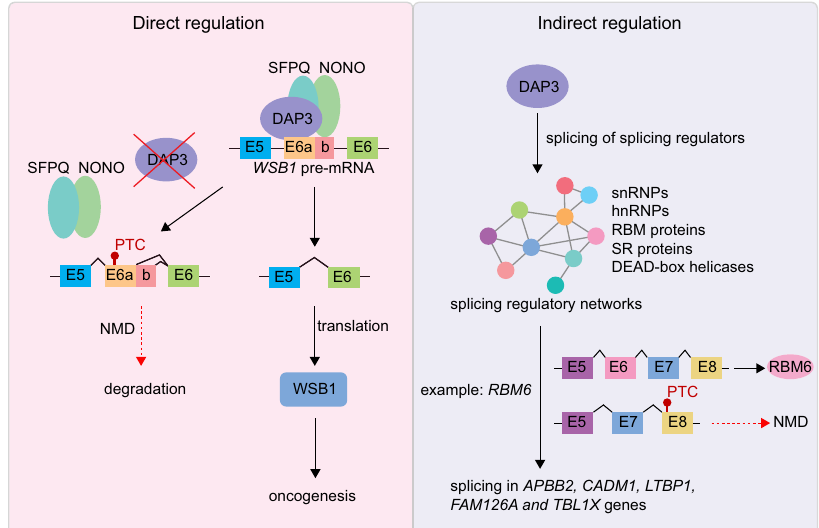
Fig. 8 Multilayered control of splicing regulatory networks by DAP3 leads to widespread alternative splicing changes in cancer. There are two distinct mechanisms of how DAP3 exerts its splicing regulatory functions. First, DAP3 directly binds to target RNA and mediates the recruitment of splicing factors, such as SFPQ and NONO, to the binding sites. Another mechanism involves indirect modulation of splicing through fi ne-tuning the splicing pattern of hundreds of splicing factors by DAP3. When DAP3 is overexpressed in many cancer types, global splicing changes can be observed and contribute to